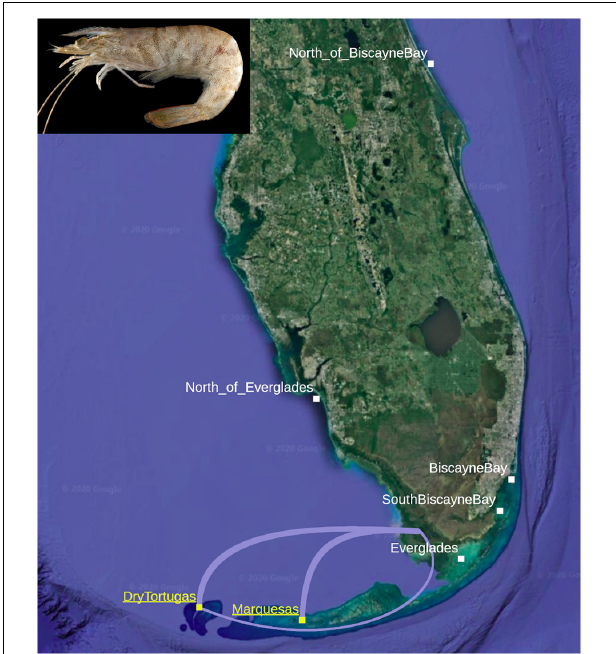
FIGURE 1 | Individuals of Farfantepenaeus duorarum were collected from seven regions around the Florida Peninsula and Florida Keys, including two spawning aggregations, DryTortugas and Marquesas (yellow and underlined). The major (thick lines) and minor (thin line) migratory routes described by Criales et al. (2015) are depicted between the spawning aggregations and the major nursery grounds in Florida Bay (Photograph of F. duorarum from wikimedia commons. Base map from Google